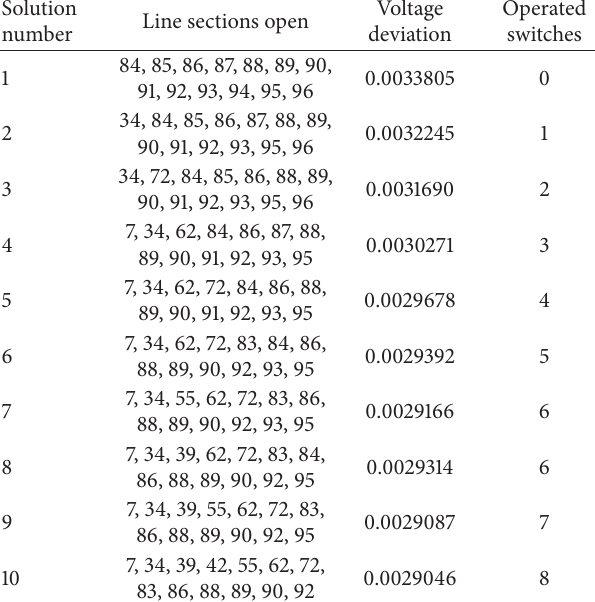
Table 3: Characteristics of the approximate Pareto-optimal solu- tions in Figure